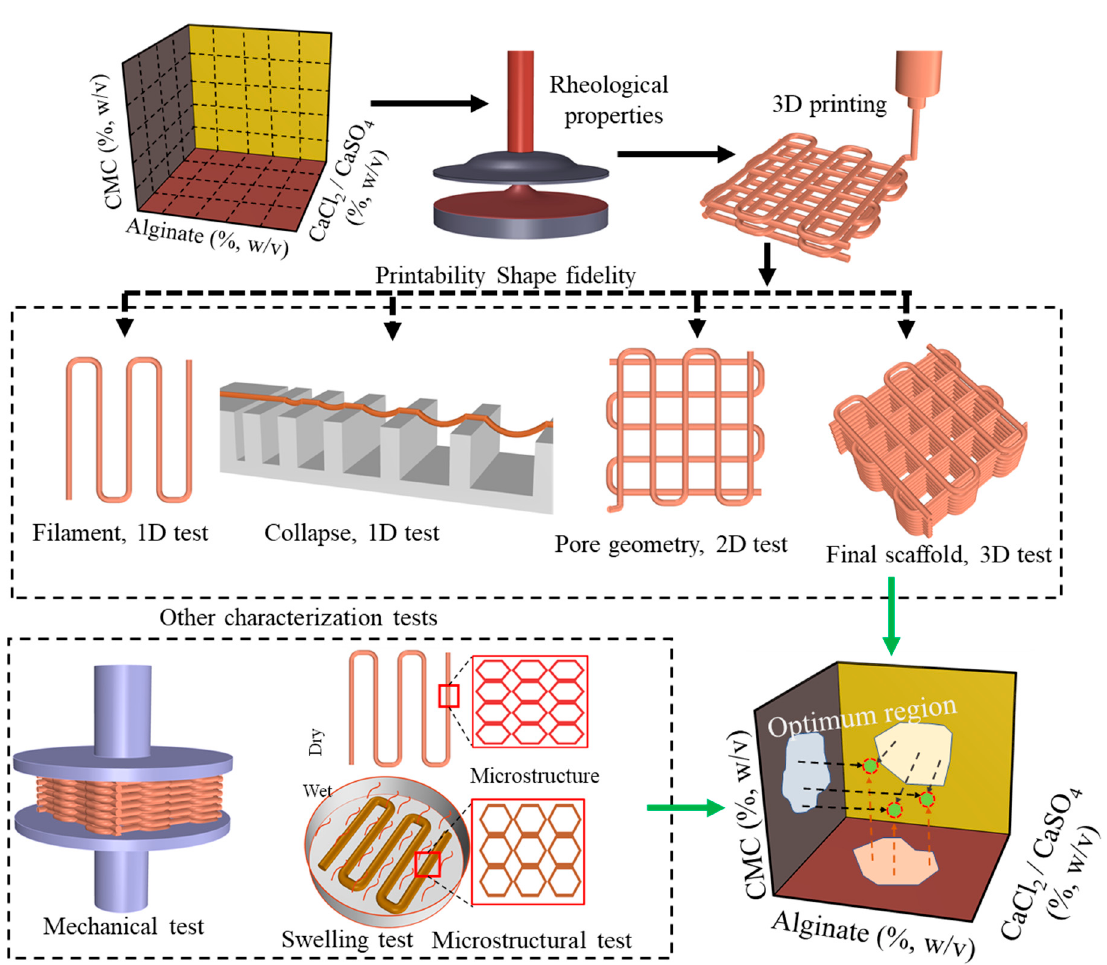
Figure 1. Schematic representation of the research: Finding out the optimum material